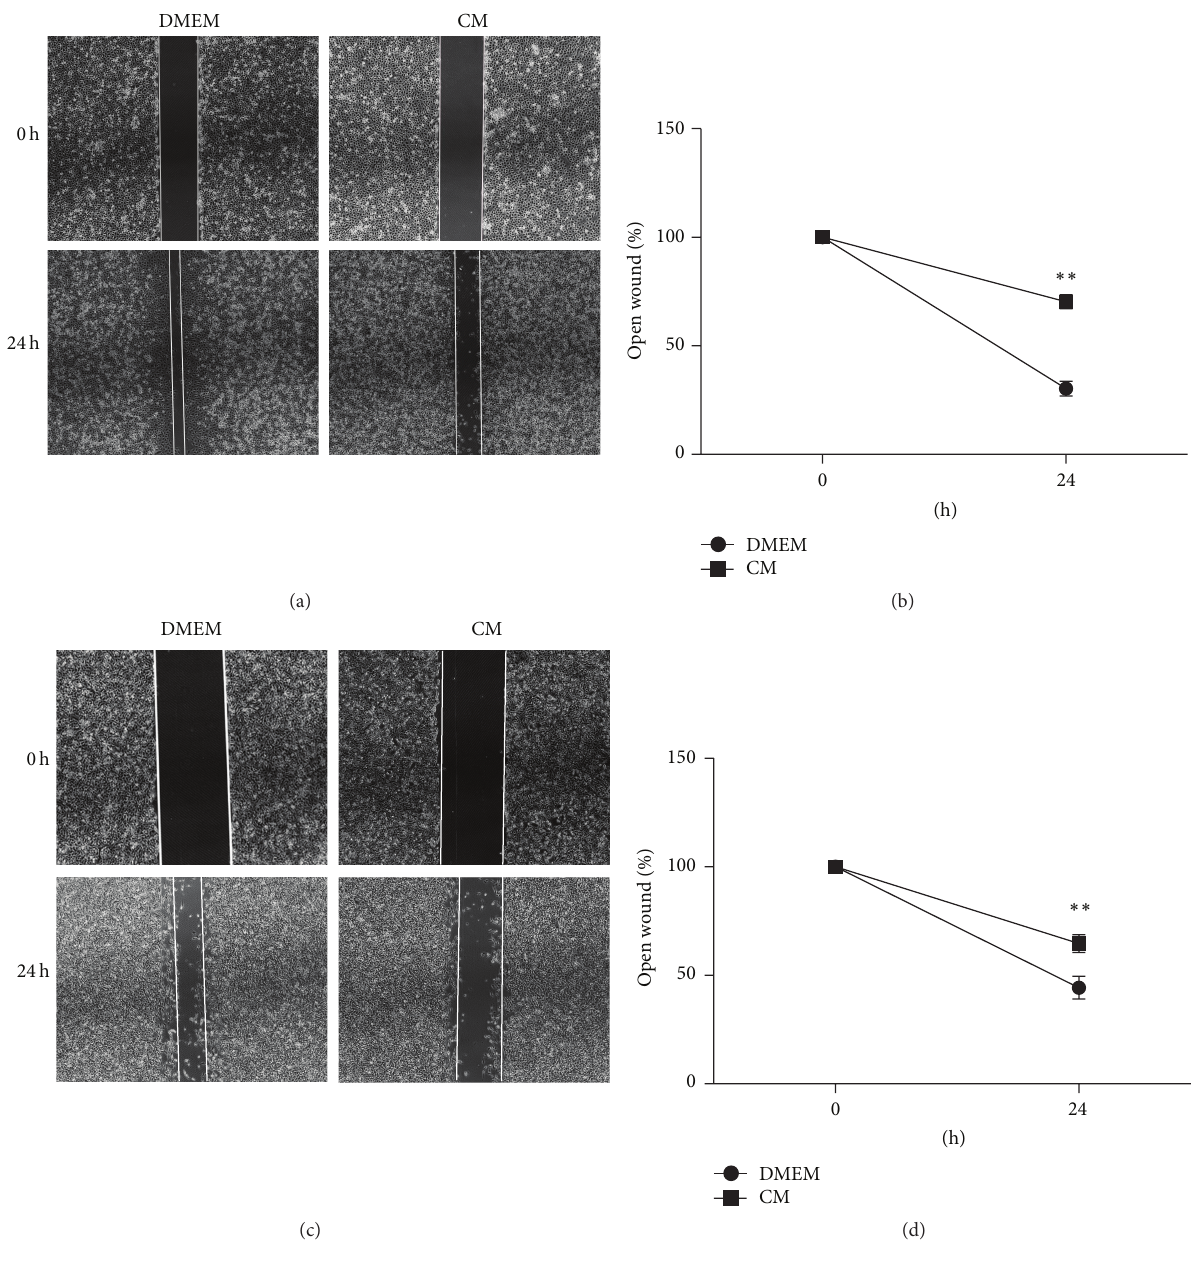
Figure 3: ADSC-CM suppresses migration of EJ and T24 cells. Representative images of wound gaps in ADSC-CM treated EJ (a) or T24 (c) cells and DMEM treated cells at different time points. Original magnification: × 40. Pictures captured at 0 or 24 h represented width of open wound compared with 0 h ( ∗∗ 𝑃 < 0.01